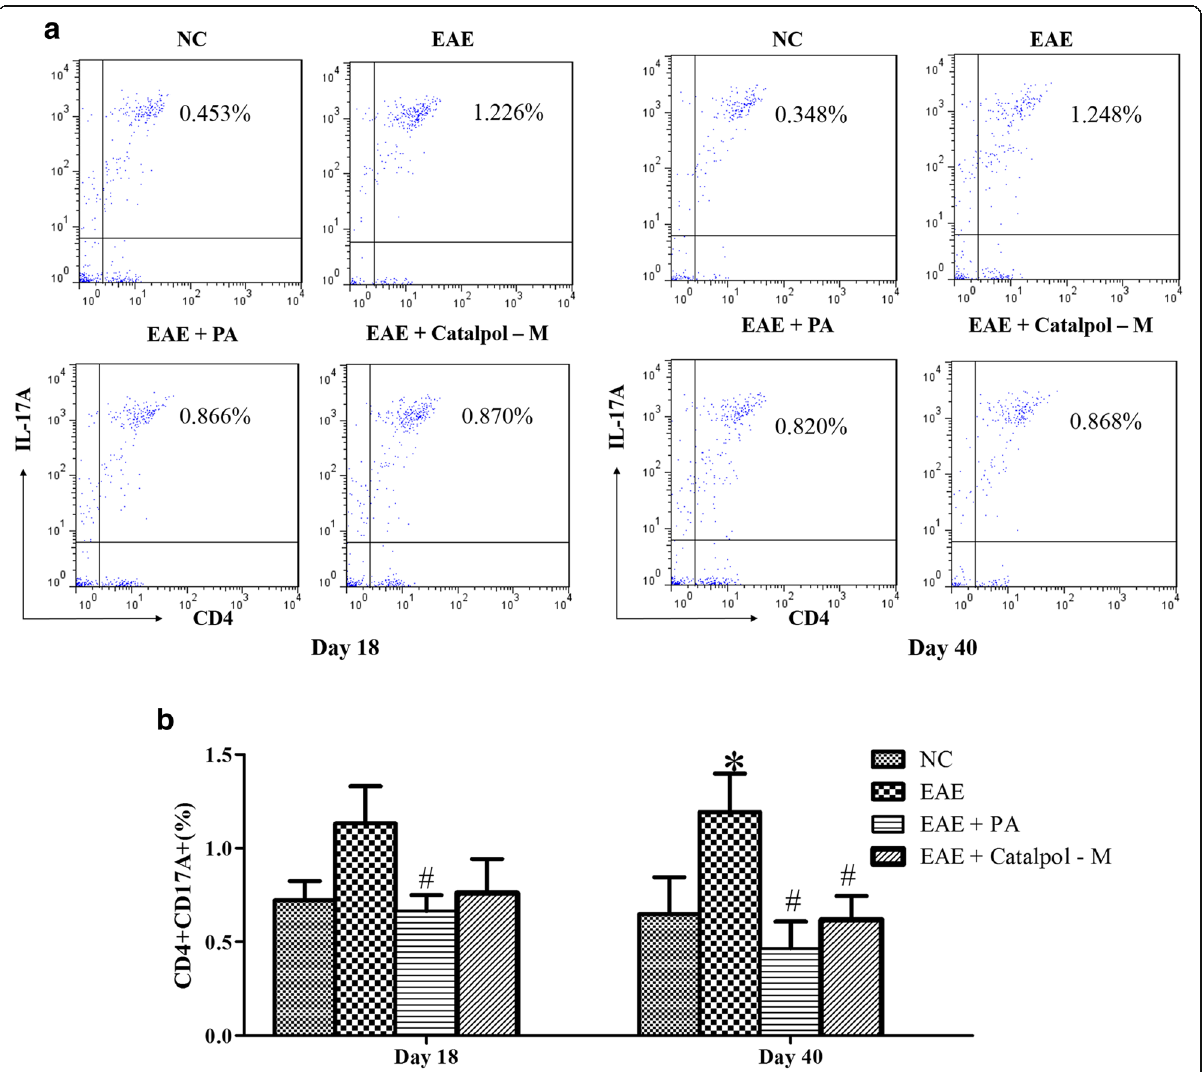
Fig. 5 Effect of Catalpol on the expression of CD4 + IL-17A + T cells in the peripheral blood on Day 18 and 40 in NC ( n = 4), EAE ( n = 4), EAE+ PA ( n = 4), EAE + Catalpol – M ( n = 4) mice. Note: * P < 0.05 vs. NC; # P < 0.05, vs.